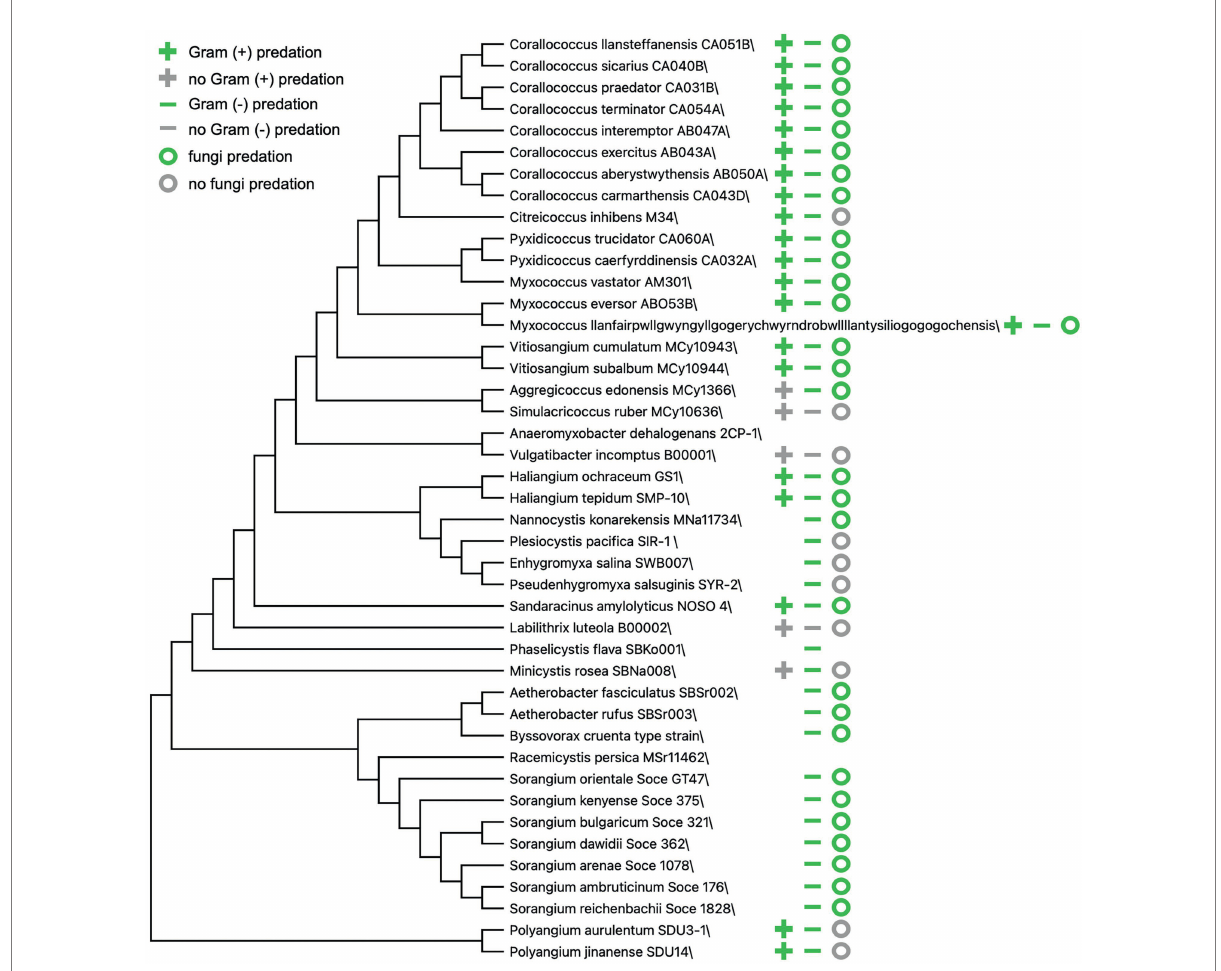
FIGURE 2 Predation data from myxobacteria type strain announcements and descriptions. Bootstrap consensus tree (300 replicates) using the Minimum Evolution method in MEGA X (Kumar et al., 2018). Absence of symbol(s) indicates no available data present in corresponding myxobacteria